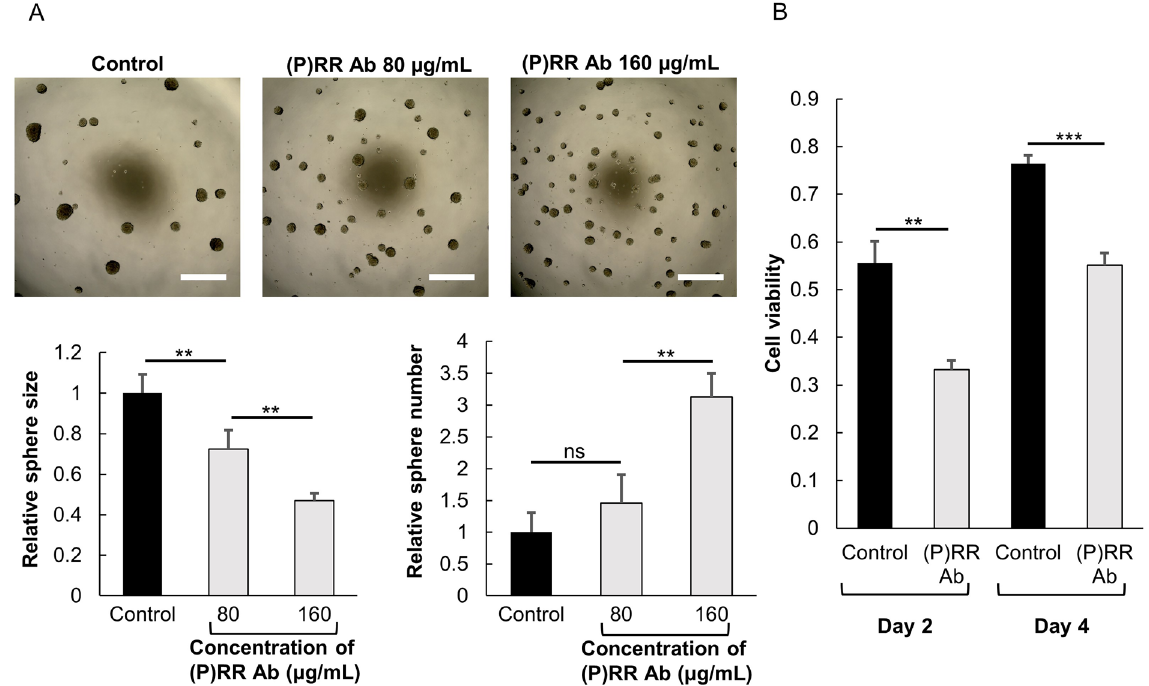
Figure 4. Antiproliferative effects of the (P)RR Ab on the human glioma stem cell line. ( A ) Dose-dependent changes in sphere formation of MGG23 after treatment with the (P)RR Ab (scale bar = 75 µm). The sphere size decreased dose-dependently, while the quantity of the spheres increased ( n = 4). ( B ) The (P)RR Ab reduced cell proliferation in the MTT assay, both dose-dependently and time-dependently ( n = 3). * P < 0.05; ** P < 0.01; *** P <